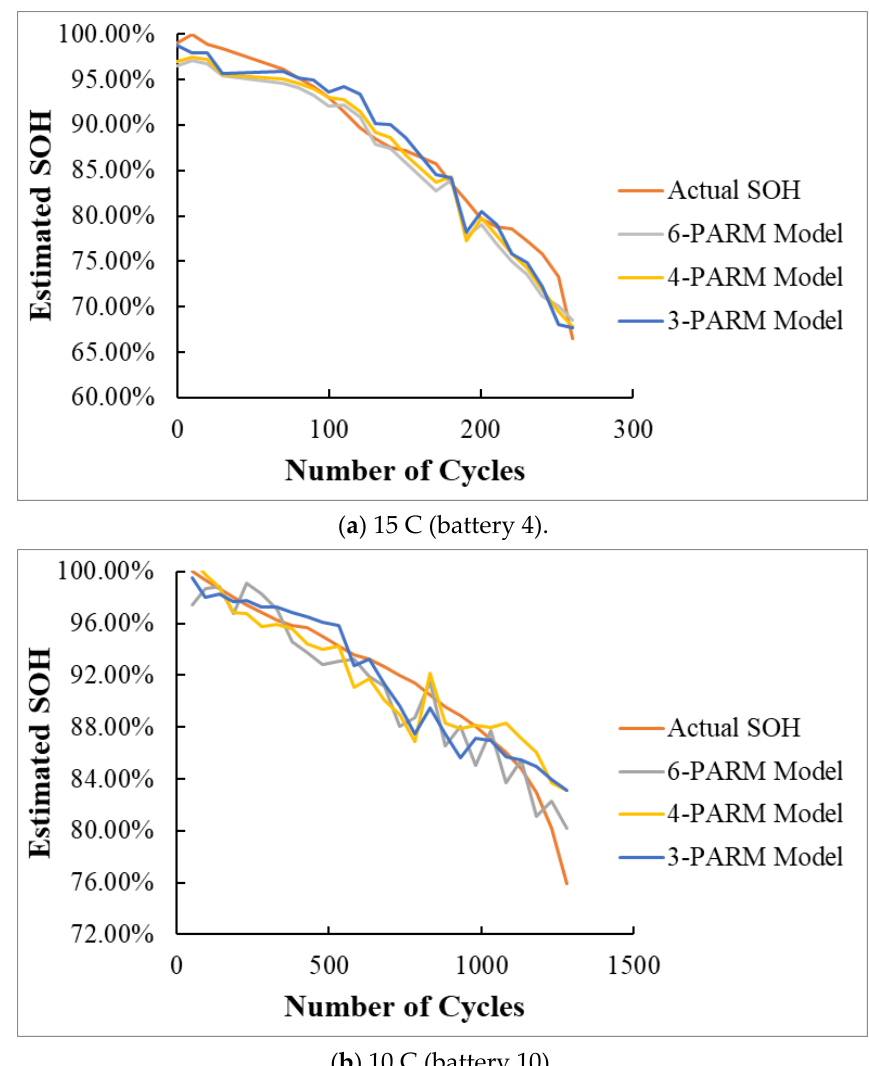
Figure 6. A comparison of the actual and predicted values of SOH (EIS method).